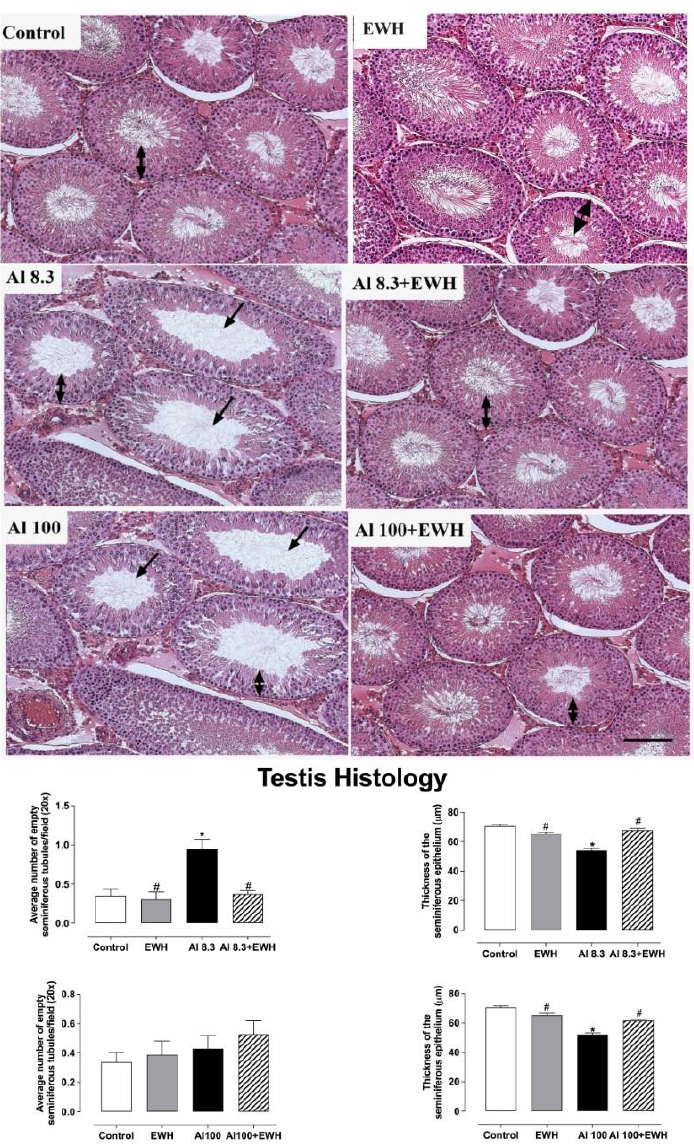
Figure 3. Effect of EWH on testis histopathology of rats exposed to AlCl 3 at 8.3 and 100 mg/kg b.w. per day. Testis sections of Al-treated rats show a reduction of spermatozoa in the lumen of the seminiferous tubules (arrows) and reduced thickness of the seminiferous epithelium ( µ m—double arrows). Rats exposed to Al and co-treated with EWH show histology analysis similar to control and EWH-treated groups. Left graphs: Average number of empty seminiferous tubules per field (20 × ) in absolute numerical values. Right graphs: Thickness of the seminiferous epithelium ( µ m). Scale bar: 50 µ m. Data are expressed as mean ± SEM, n = 6, * p < 0.05 compared with their corresponding controls, # p < 0.05 compared with AlCl 3 group (two-way ANOVA and Bonferroni as post-hoc